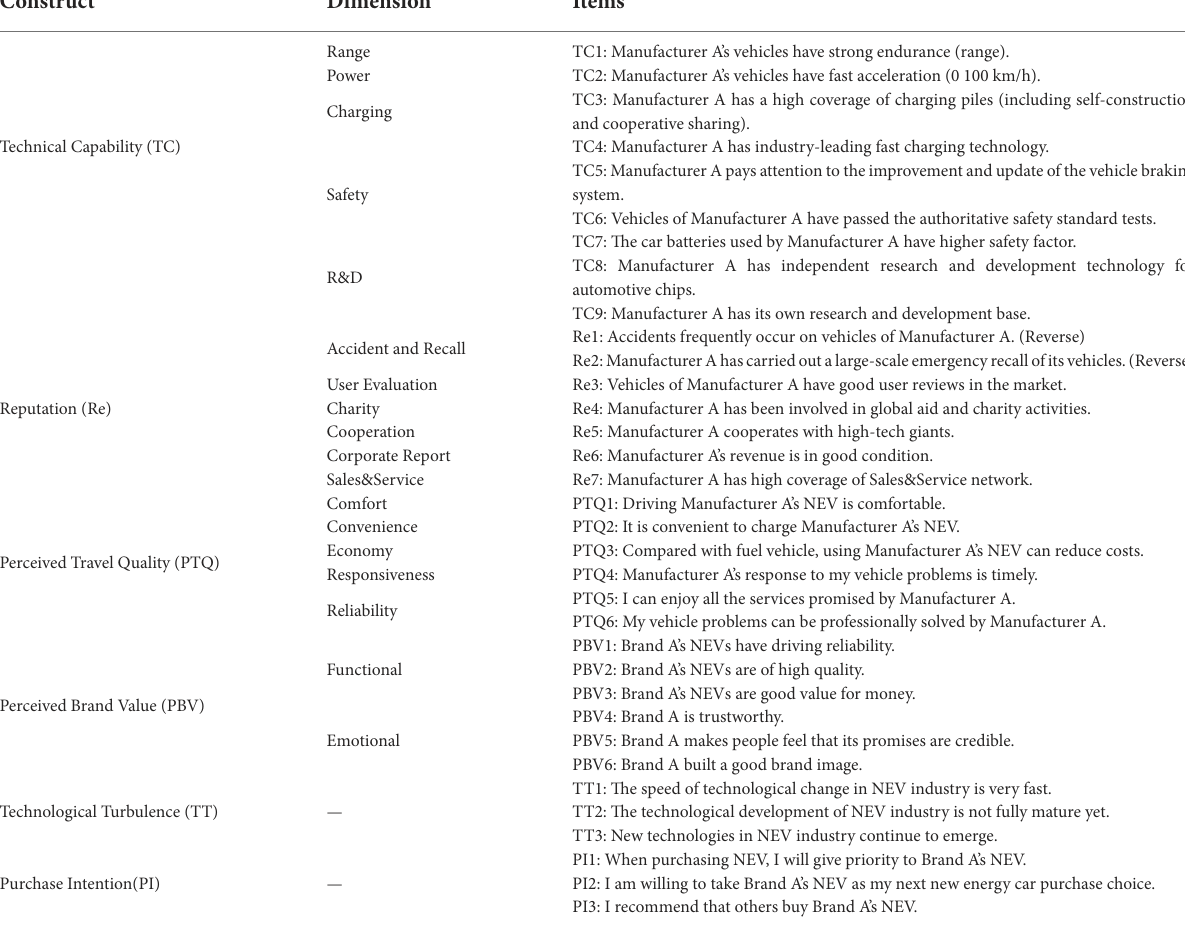
TABLE 1 Variabledesignandmeasurementitems.